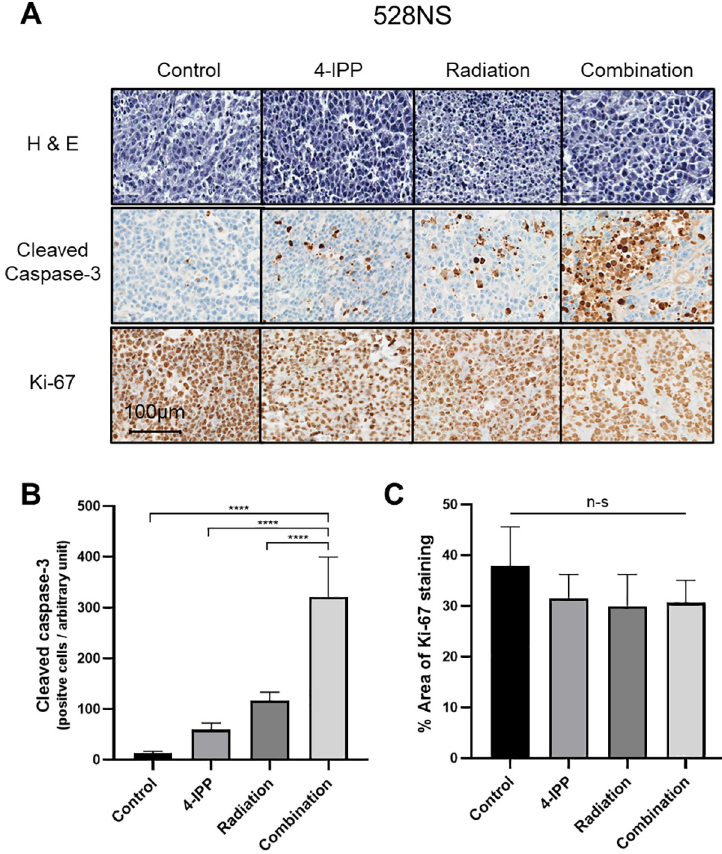
Fig 4. Cleaved caspase-3 and Ki-67 immunohistochemical stain on ex vivo tissue explants. (A) Representative images for cleaved caspase-3 and Ki-67 are shown. Scale bar, 100 μ m. (B) The summary of the quantitative analysis results for cleaved caspase-3 and (C) Ki-67 is shown. The data represents the mean value of the number of cleaved caspase-3-positive cells per arbitrary unit (n = 5) and the percentage of Ki-67-positive stained area for each selected tissue area (n = 5). P values: ���� p <